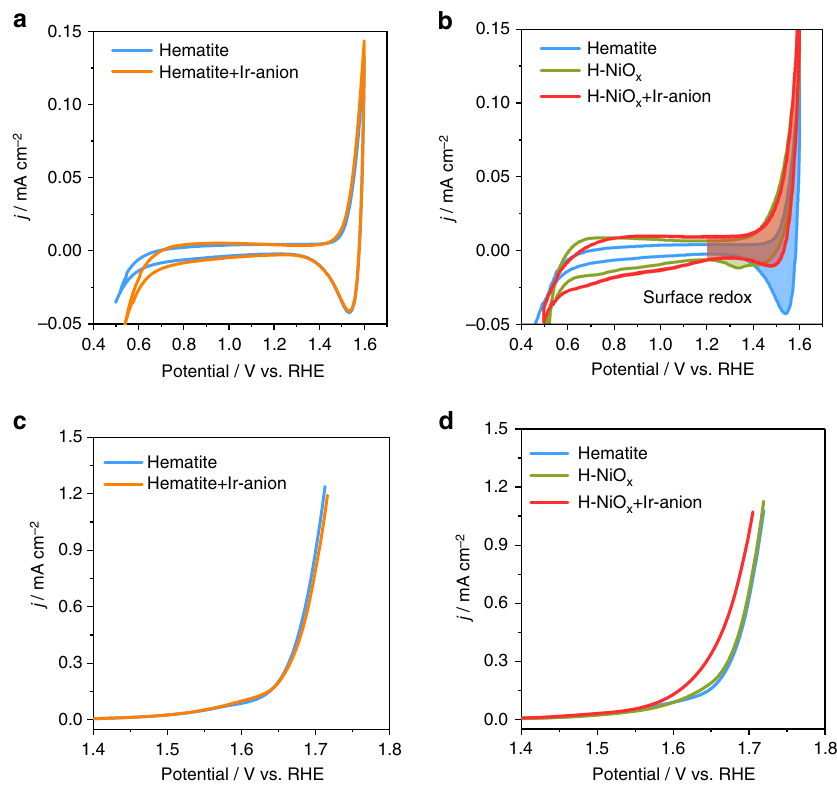
Fig. 4 Charge transfer and activity enhancement. a , b Cyclic voltammetry at 50 mV s − 1 and c , d linear sweep voltammetry at 10 mV s − 1 on pristine hematite and H-NiO x in 1.0 M NaOH in the dark. The concentration of Ir-anion is 1.0 µ